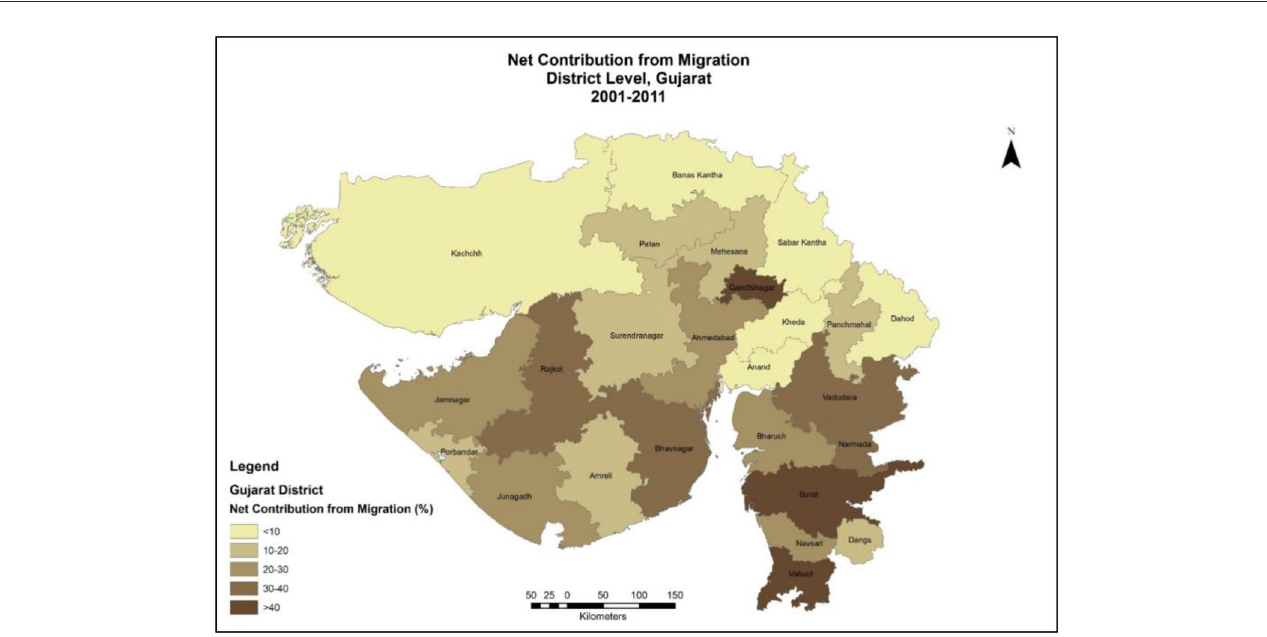
FIGURE7 Per centage contribution of migration to the levels of urbanization. Source: Primary Census Abstract, Census of India (2001; 2011) Migration Table D 02, Source of distribution Map: